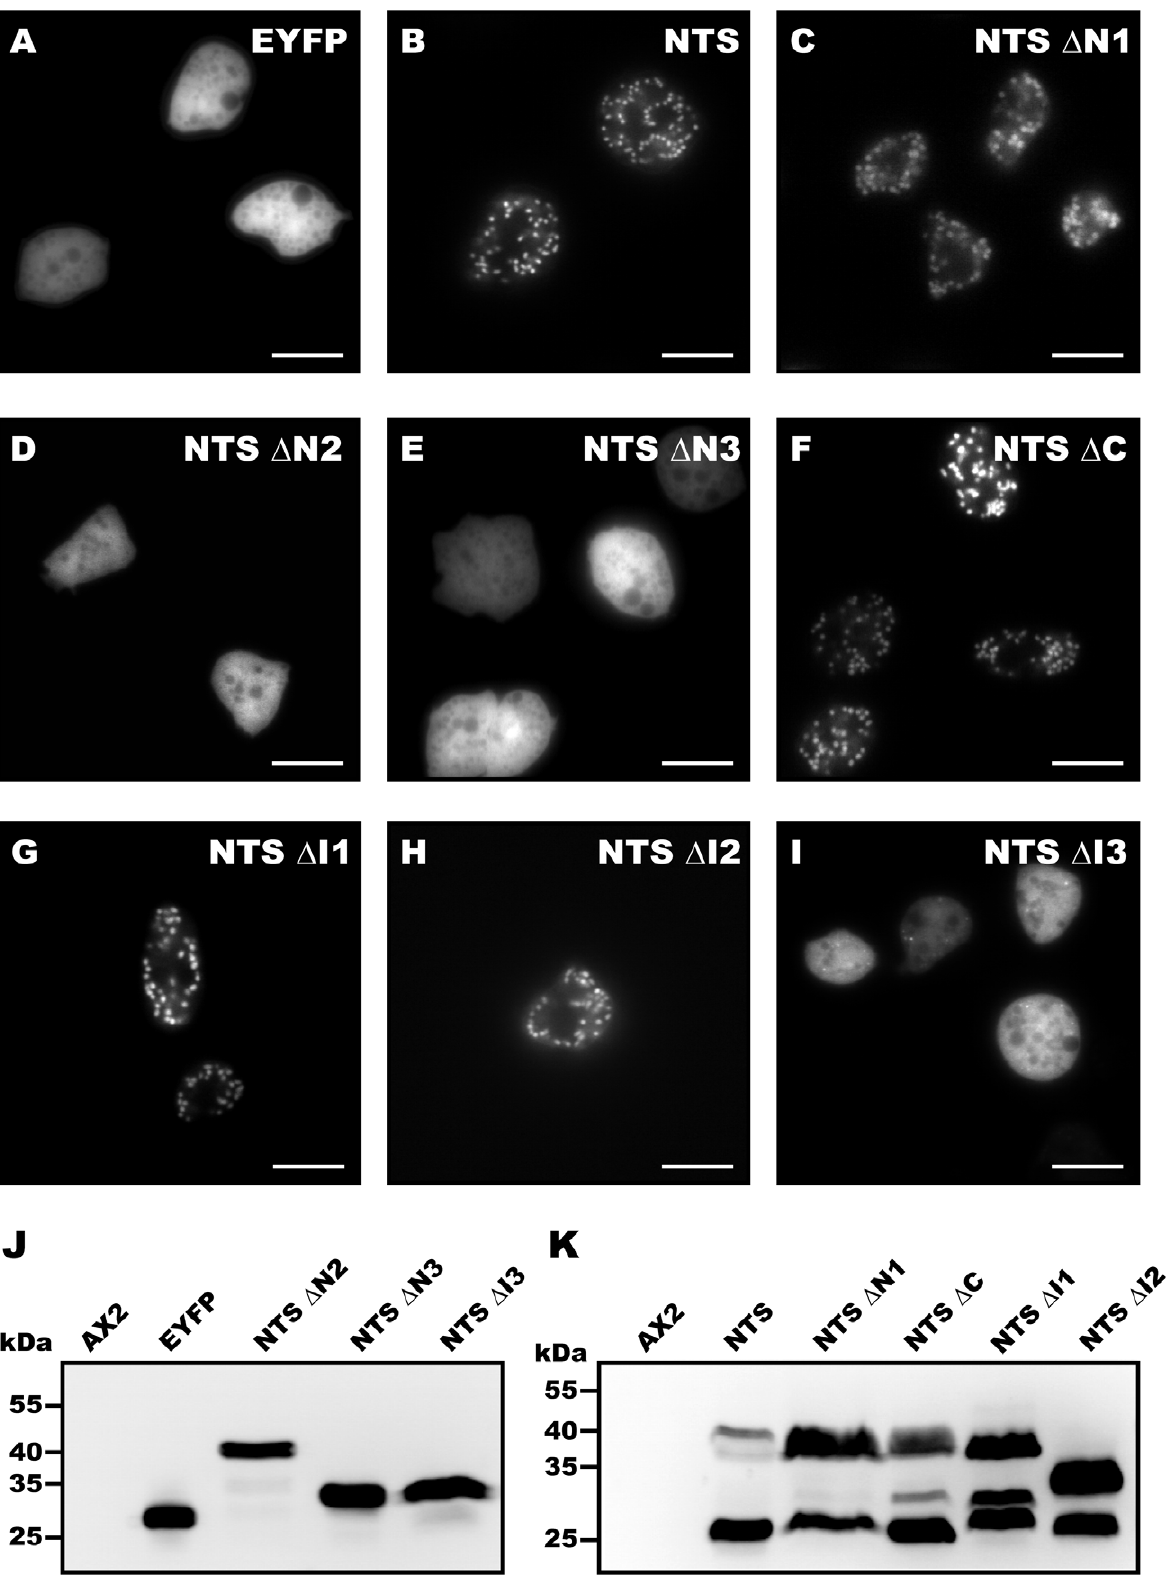
Figure 3. Residues 28–64 within the dynamin B presequence (NTS) are required for mitochondrial targeting. ( A–I ) AX2 cells were transformed with EYFP or with the indicated NTS fragments fused to EYFP. Images of live cells were taken by epi-fluorescence microscopy. Diffuse staining indicates cytoplasmic localization and granular staining indicates mitochondrial localization. Scale bars, 10 m m. ( J–K ) Mitochondrial targeted